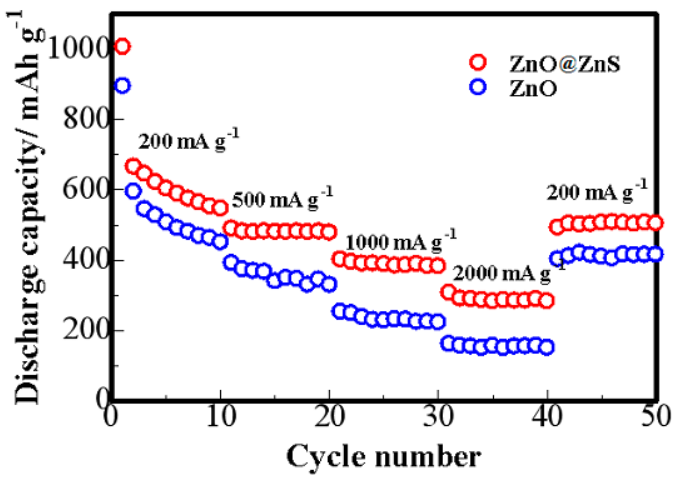
Figure 4. Rate capabilities of the ZnO and ZnO@ZnS electrodes at different current densities.